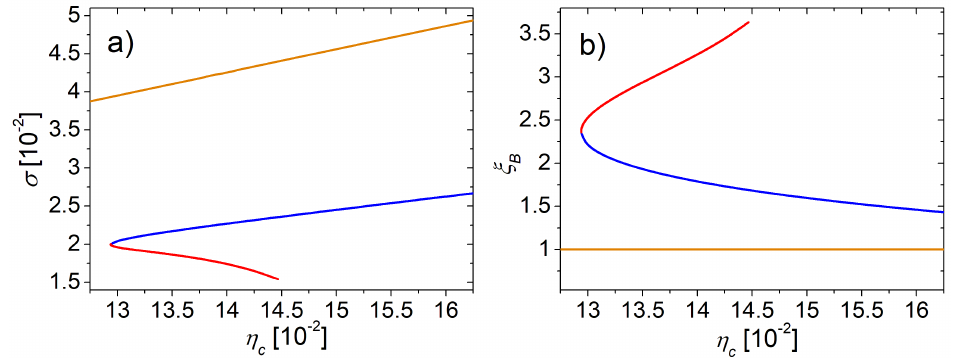
Figure 2. Mean particle density σ ( a ) and system radius ξ B ( b ) as functions of central density η c in two models. In both panels the orange line corresponds to the model with pair interaction in the Thomas–Fermi approximation. The red and blue branches of the single curve correspond to the model that takes into account both quantum fluctuations and three-particle